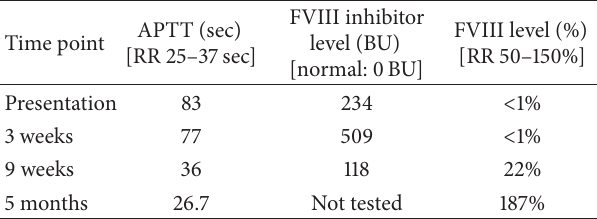
Table 1: APTT, FVIII level, and inhibitor level over